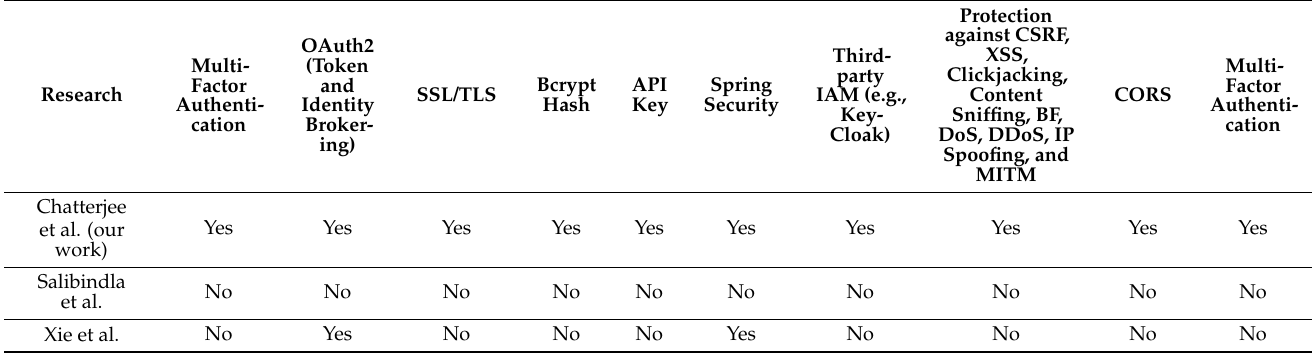
Table 18. Comparative analysis of our security solution with existing MSSA with respect to the implemented security